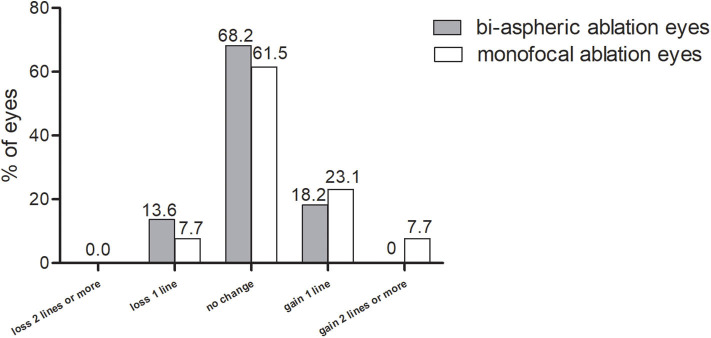
Changes in corrected distance visual acuity at 1 year postoperatively. CDVA, corrected distance visual acuity.